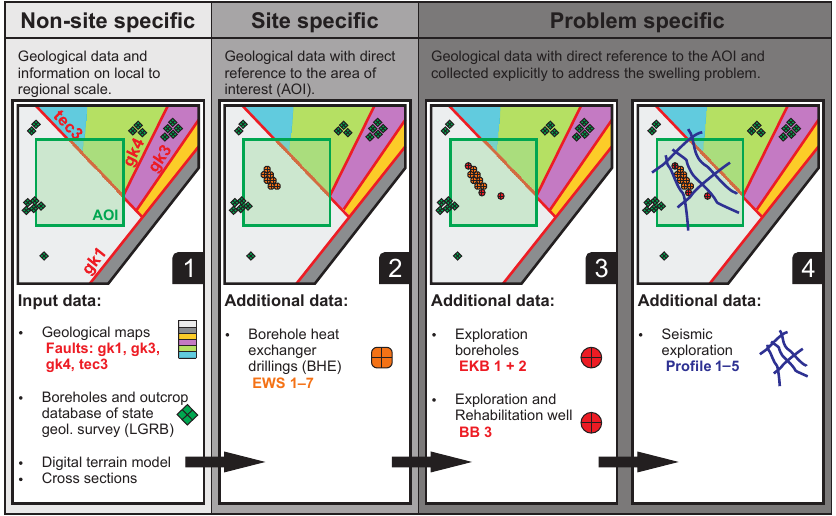
Figure 2. Data categories and geological input data used to build four initial 3-D geological models. The green square indicates the area of interest (AOI), where data were extracted for further analysis. For geological formation color code, see Fig. 1.